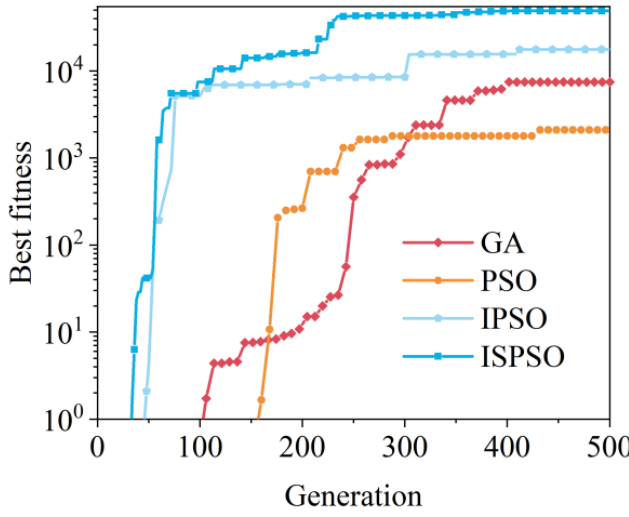
Figure 2. The best fitness variation under GA, PSO, IPSO, and ISPSO algorithms.